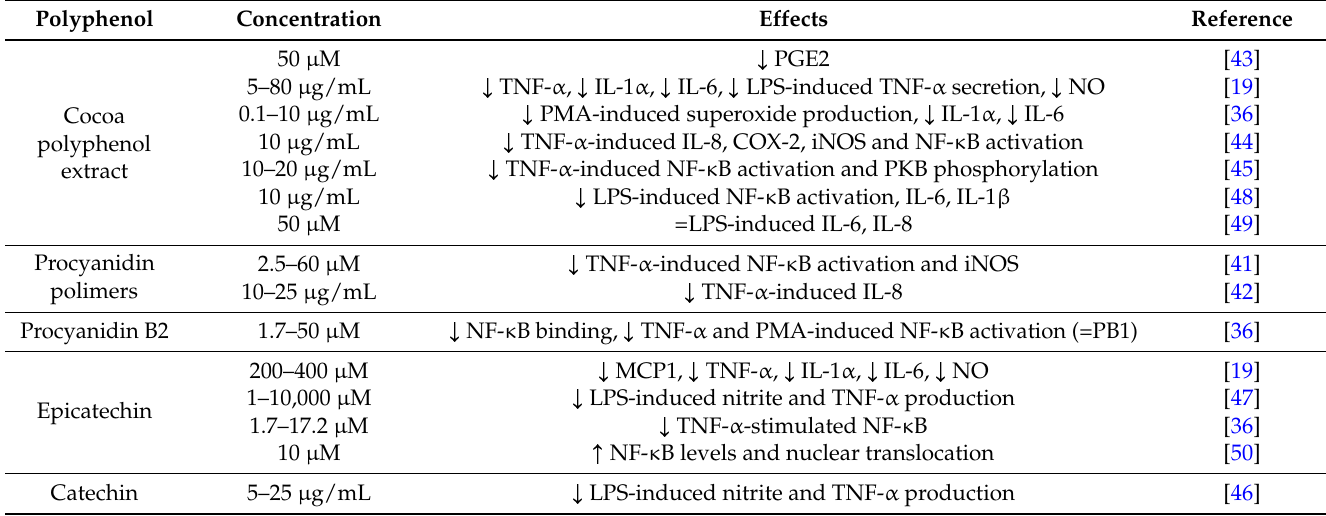
a The arrow indicates an increase ( (cid:210) ) or decrease ( (cid:211) ) in the levels or activity of the different analyzed proteins. PGE: prostaglandin E; PMA: phorbol 12-myristate 13-acetate; TNF: tumor necrosis factor; IL: interleukin; LPS: lipopolysaccharide; COX: cyclo-oxygenase; NOS: nitric oxide synthase; NF- κ B: nuclear factor kappa B; PKB: protein kinase B; MCP: monocyte chemoattractant